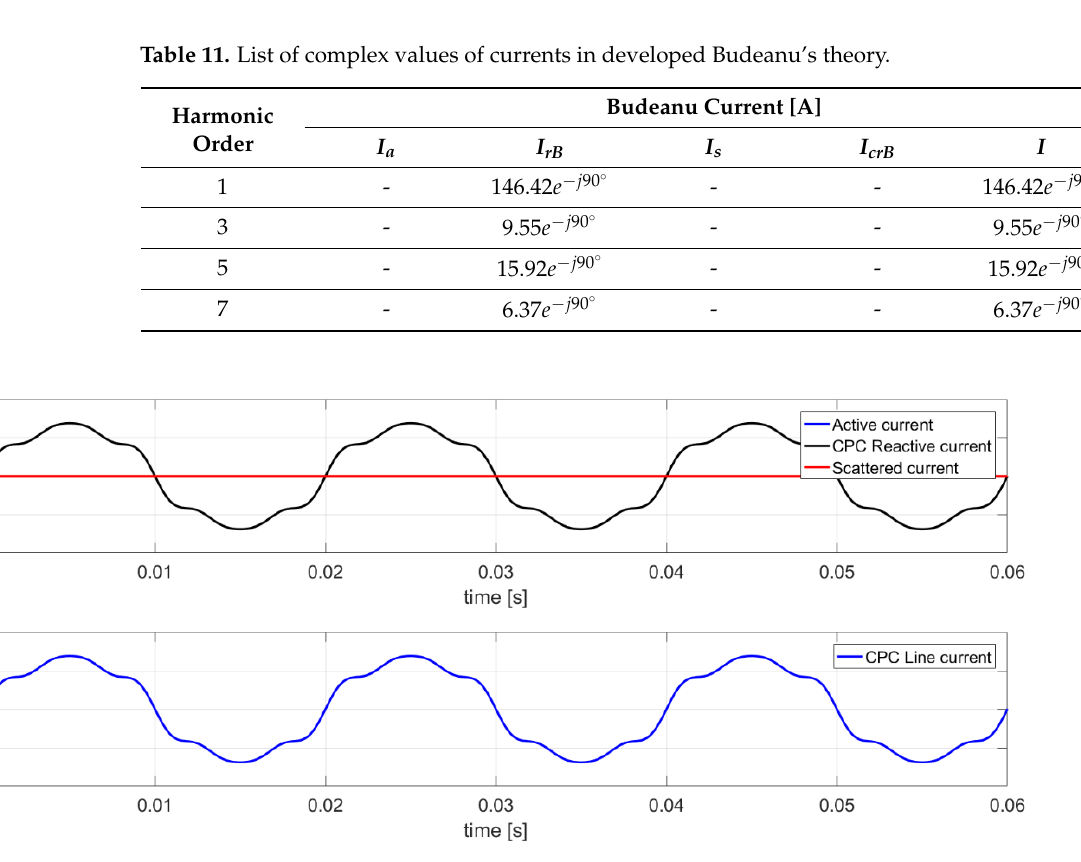
Table 11. List of complex values of currents in developed Budeanu’s theory.